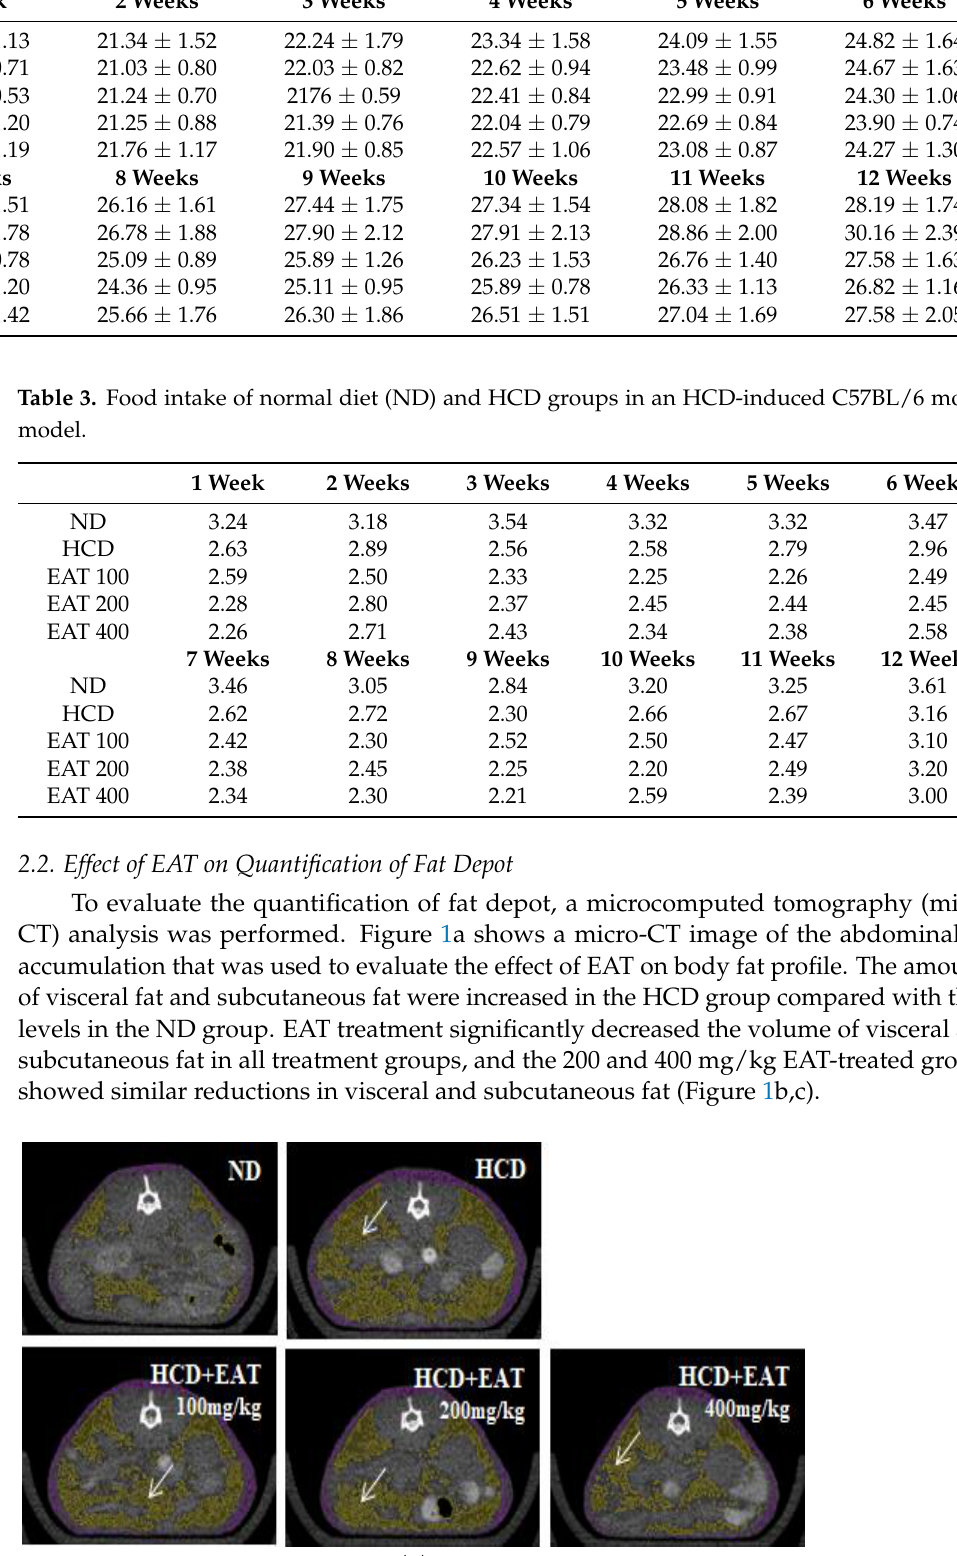
Table 2. Effect of ethanol extract of Amomum tsao-ko (EAT) on body-weight change in a high-carbohydrate diet (HCD)-induced C57BL/6 mouse model.